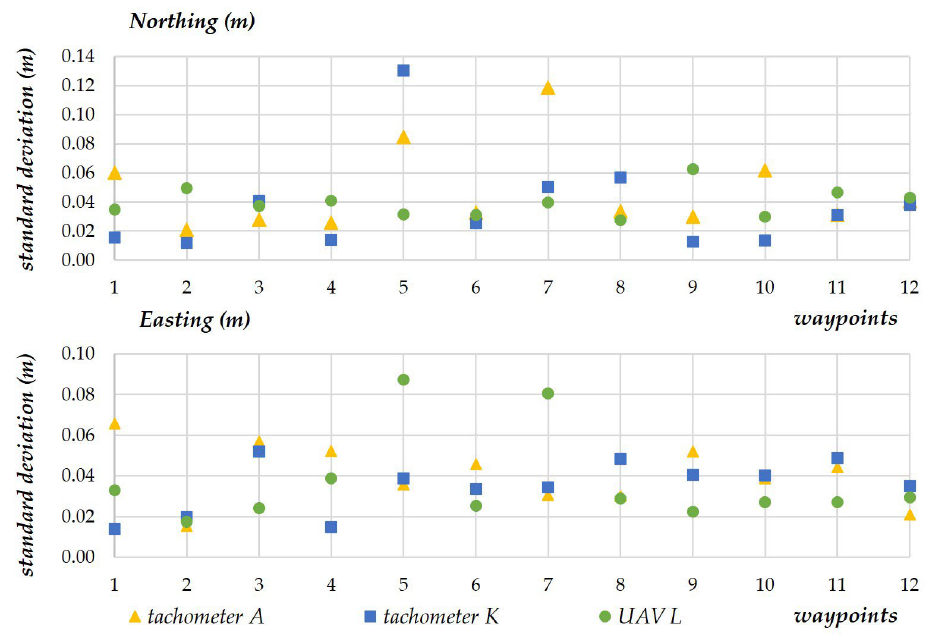
Figure 10. Standard deviation for every measuring device.